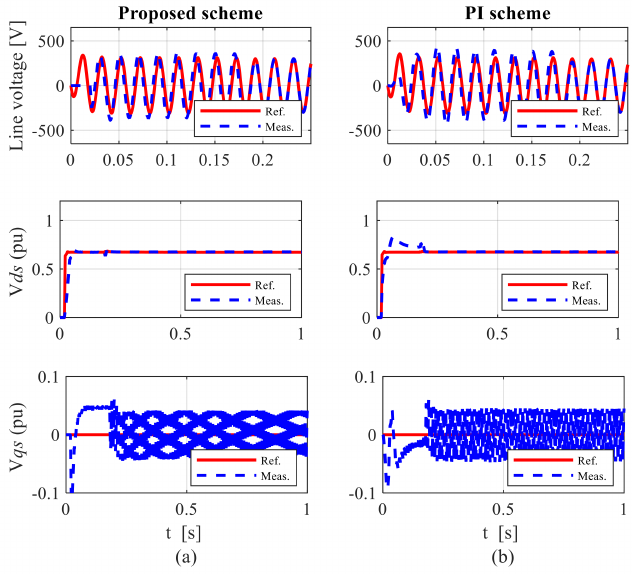
Figure 10. Control performances during super-synchronous speed operation under unbalanced grid conditions: ( a ) proposed scheme and ( b ) PI